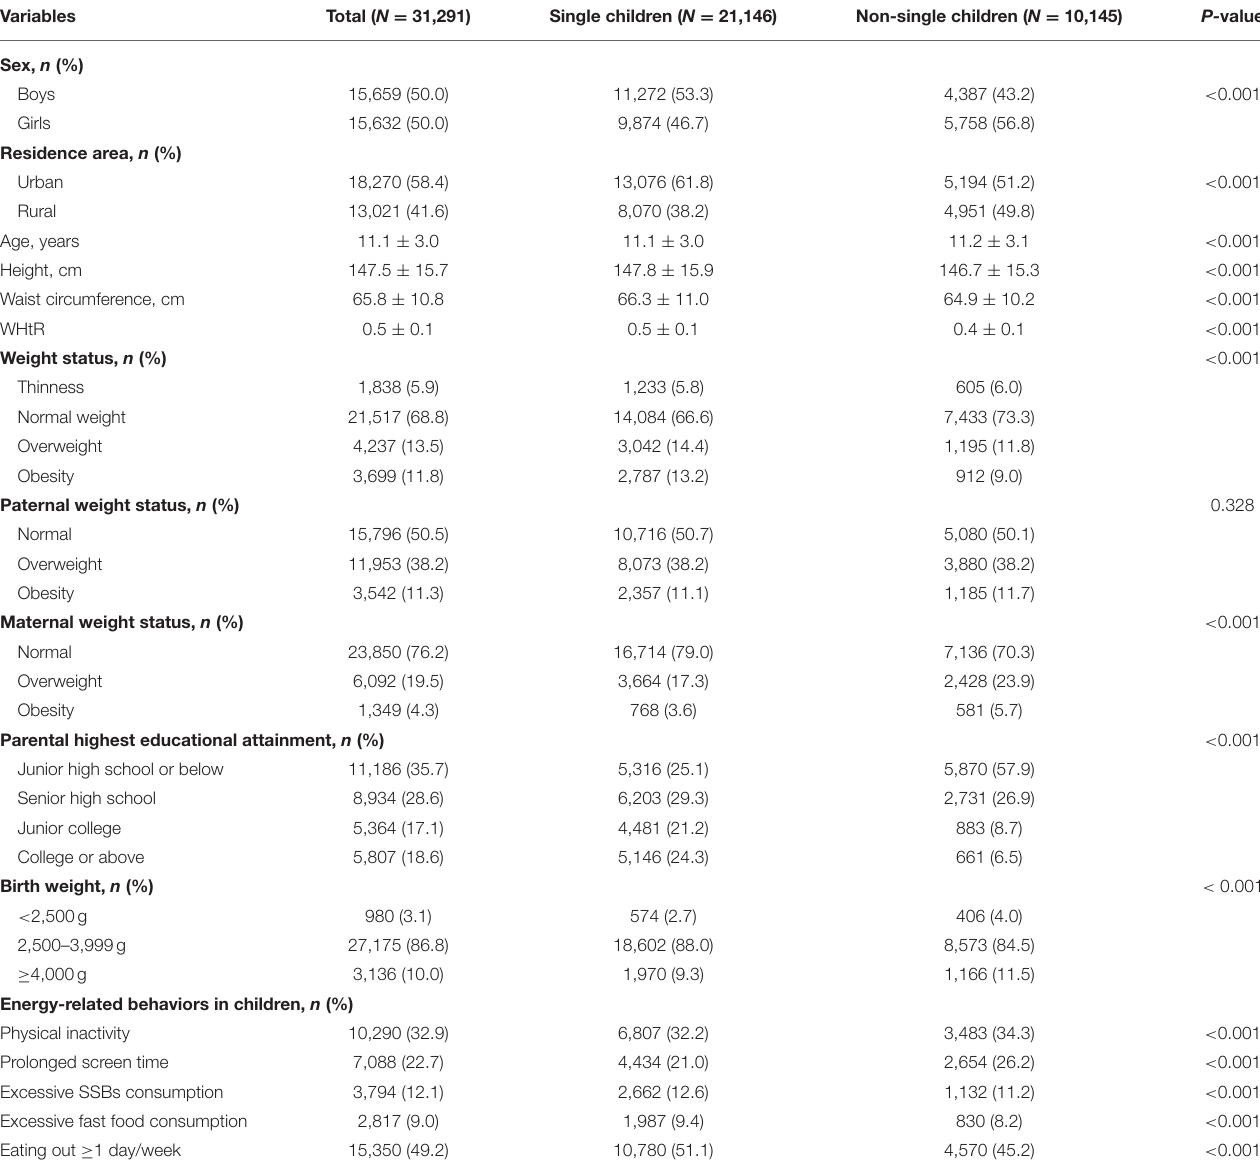
TABLE 1 | Descriptive characteristics [mean (SD) or n (%)] of the study participants by single-child status.